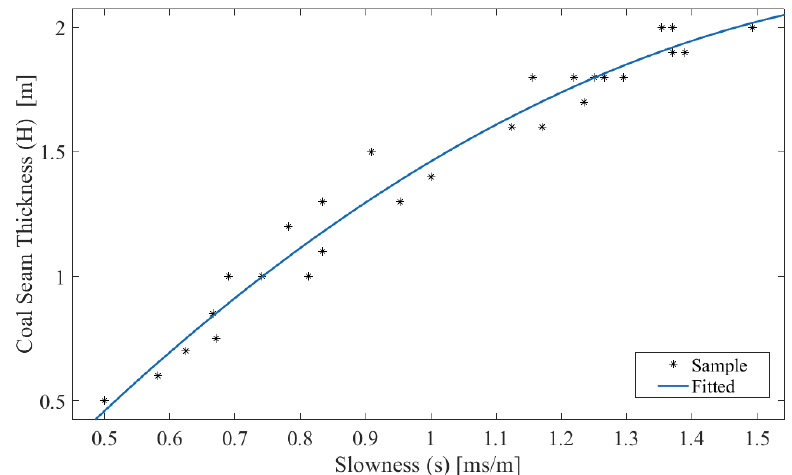
Figure 5. Fitting result between coal seam thickness ( H ) and slowness ( s ). The fitting equation is H = 0.185 s 2 + 0.124 s + 0.433, where the coefficient of determination R 2 = 0.9654 and the root mean square error RMSE = 0.087.